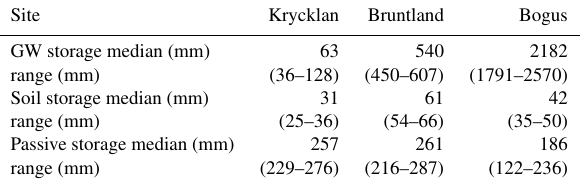
Table 2. Simulated catchment average storages in groundwater stor- age, soil storage (water), and passive soil storage (isotope mixing) for experimental catchments in the 100 behavioural runs. Range of storage is shown as 0.25–0.75 percentile of medians to demonstrate typical ranges in behavioural